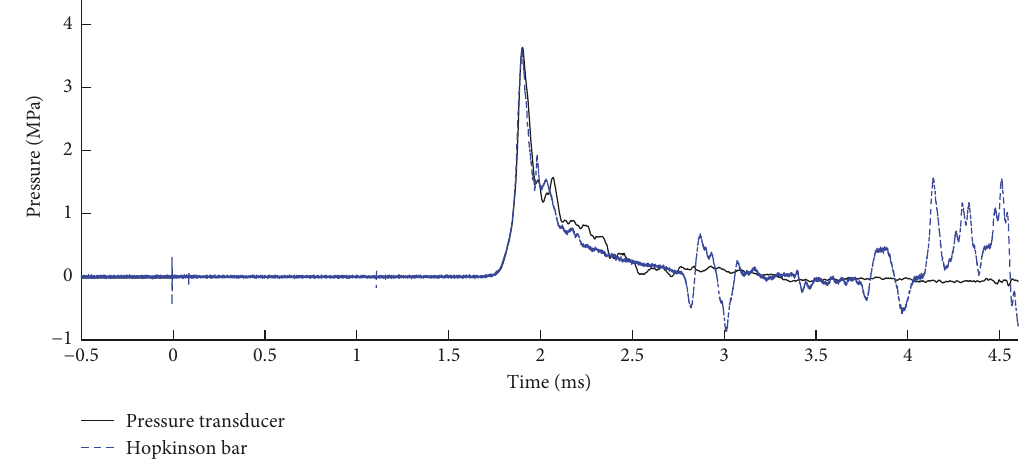
Figure 9: The comparison between pressure-time profiles obtained by Hopkinson bar and pressure transducer.